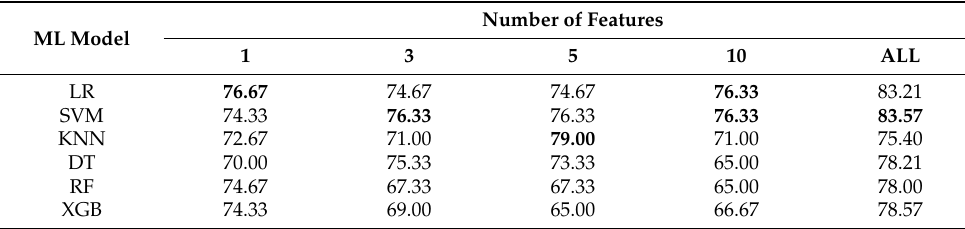
Table 10. KOA vs. HC accuracy of feature